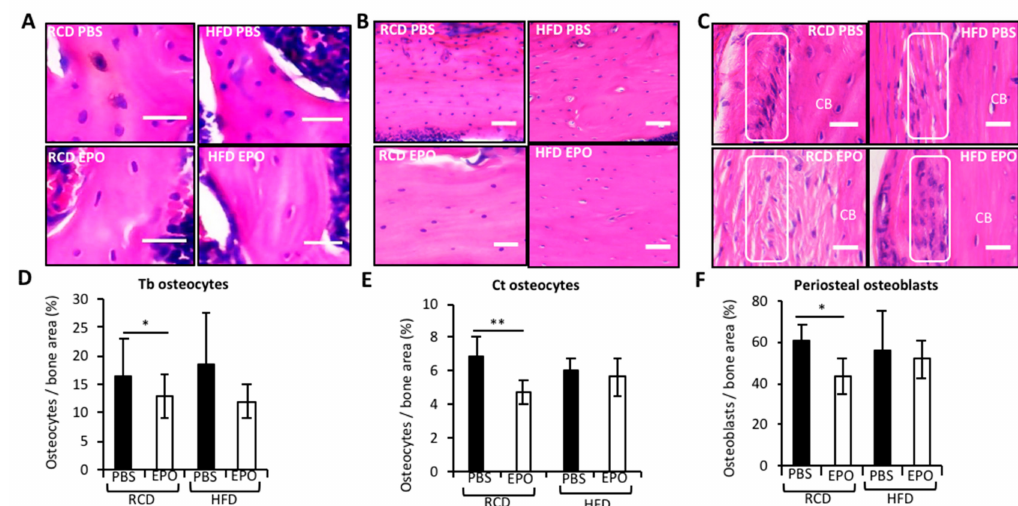
Figure 3. Histology analysis following EPO administration in RCD and HFD-fed mice. ( A – F ) The corresponding histology analysis of femurs. ( A ) The H & E staining of osteocytes (blue) embedded in trabecular bone (pink), scale 25 µ m, ( B ) the cortical bone with osteocytes, scale 100 µ m, ( C ) the periosteal region of bone containing osteoprogenitor cells adjacent to cortical bone (CB). Cells were counted within the region of interest in the periosteum indicated by the white box, scale 100 µ m. ( D ) The enumeration of trabecular osteocytes, ( E ) cortical osteocytes and ( F ) periosteal osteoblasts. n = 6 mice / group, * p < 0.05, ** p < 0.01.